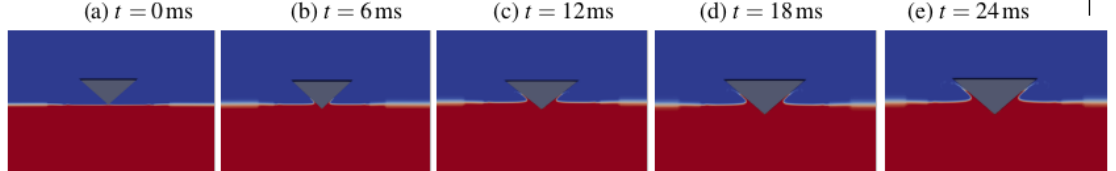
Figure 6. Evolution of the free surface during water impact for h = 0.5 m. CFD results for: ( a ) t = 0 ms; ( b ) t = 6 ms; ( c ) t = 12 ms; ( d ) t = 18 ms; ( e ) t = 24